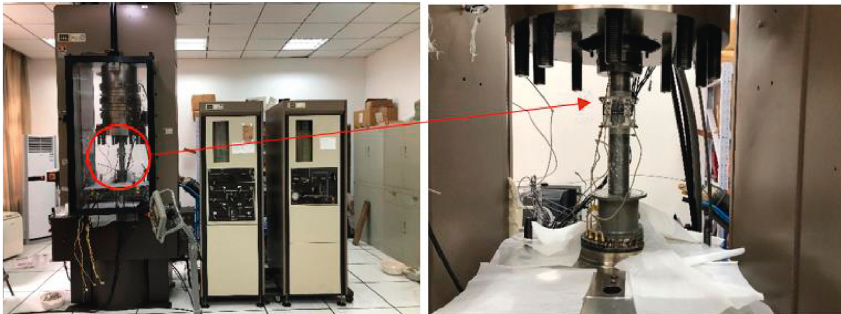
Figure 3: Obtaining conventional mechanical parameters of rock by MTS test equipment.